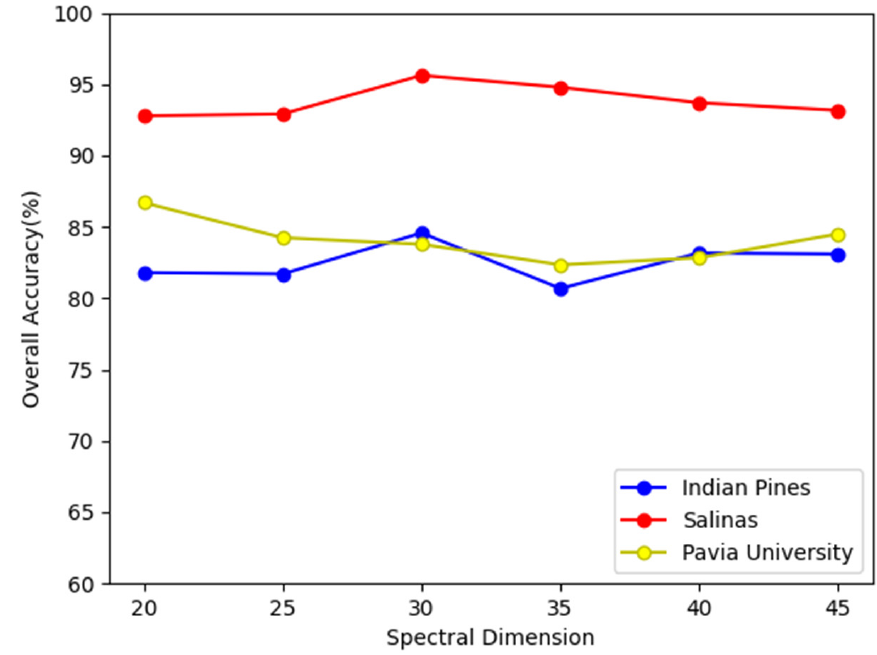
Figure 11. OA of the proposed model using different spectral dimension in three HSI datasets.